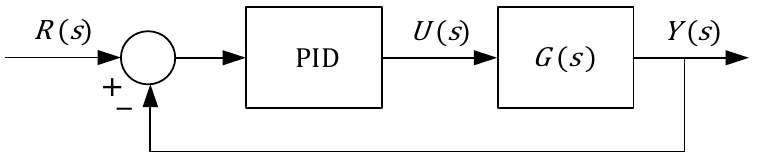
Figure 4. PID controller in a classic closed-loop scheme (Laplace domain).